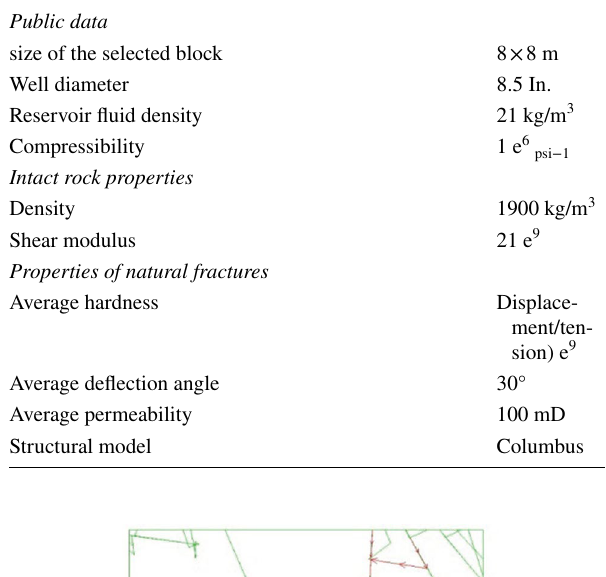
Table 1 Data used in the discrete element method